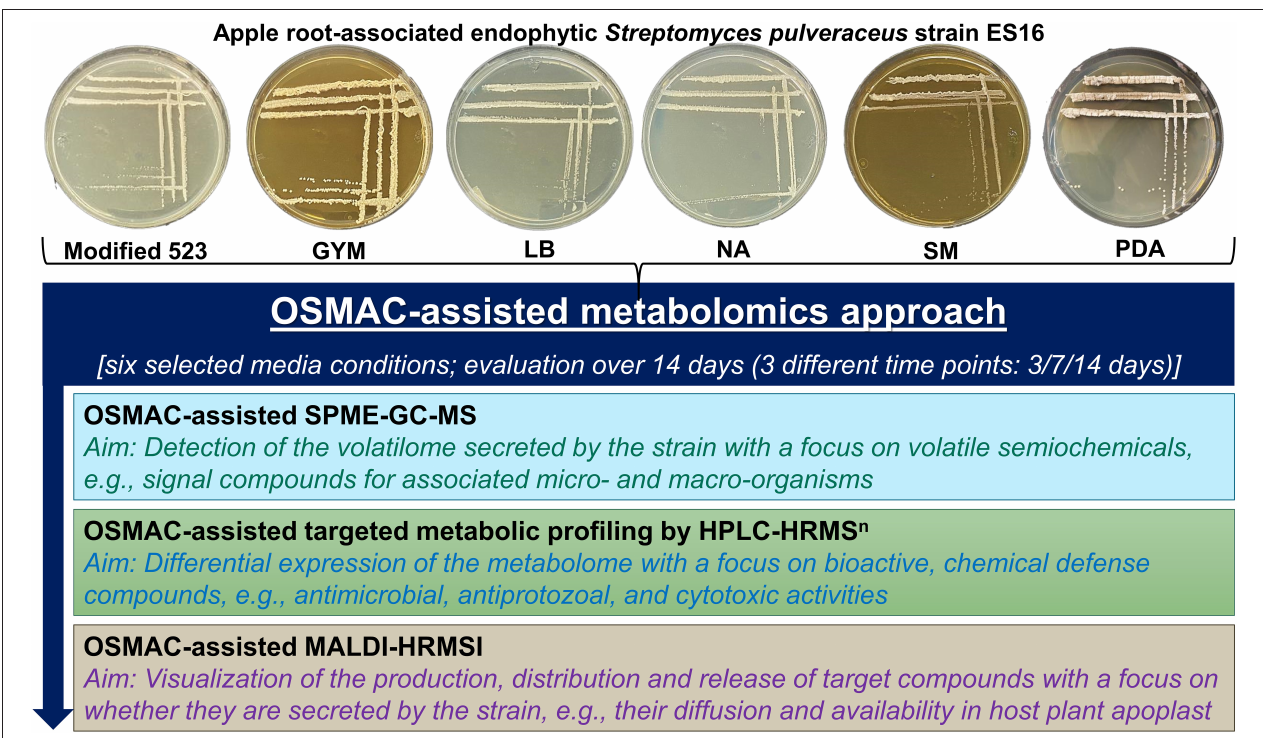
FIGURE 1 | Schematic representation of the overview of workflow employed in the present study. GYM, glucose yeast malt medium; LB, lysogeny medium; NA, nutrient agar; SM, streptomyces medium; PDA, potato dextrose agar.